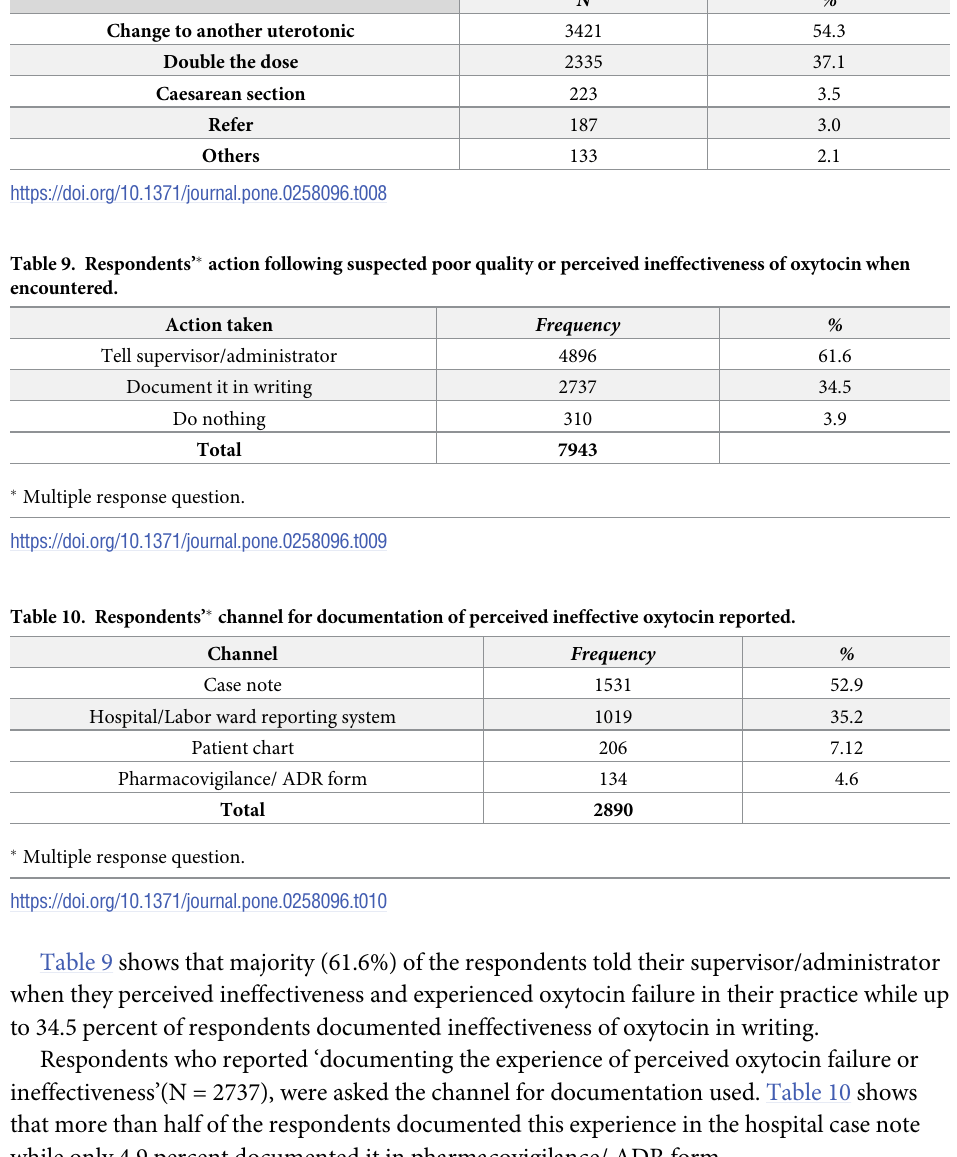
Change to another uterotonic Double the dose